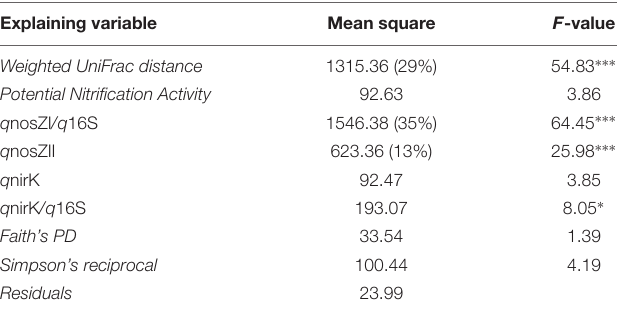
TABLE 1 | Predicting the aggregated impact of compounded disturbances on ecosystem properties and